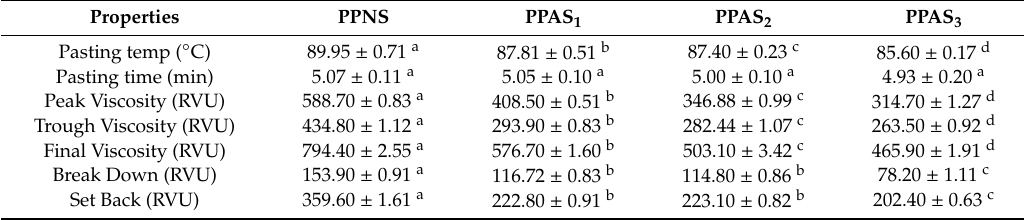
Table 2. Pasting properties of native and acetylated pigeon pea starch.